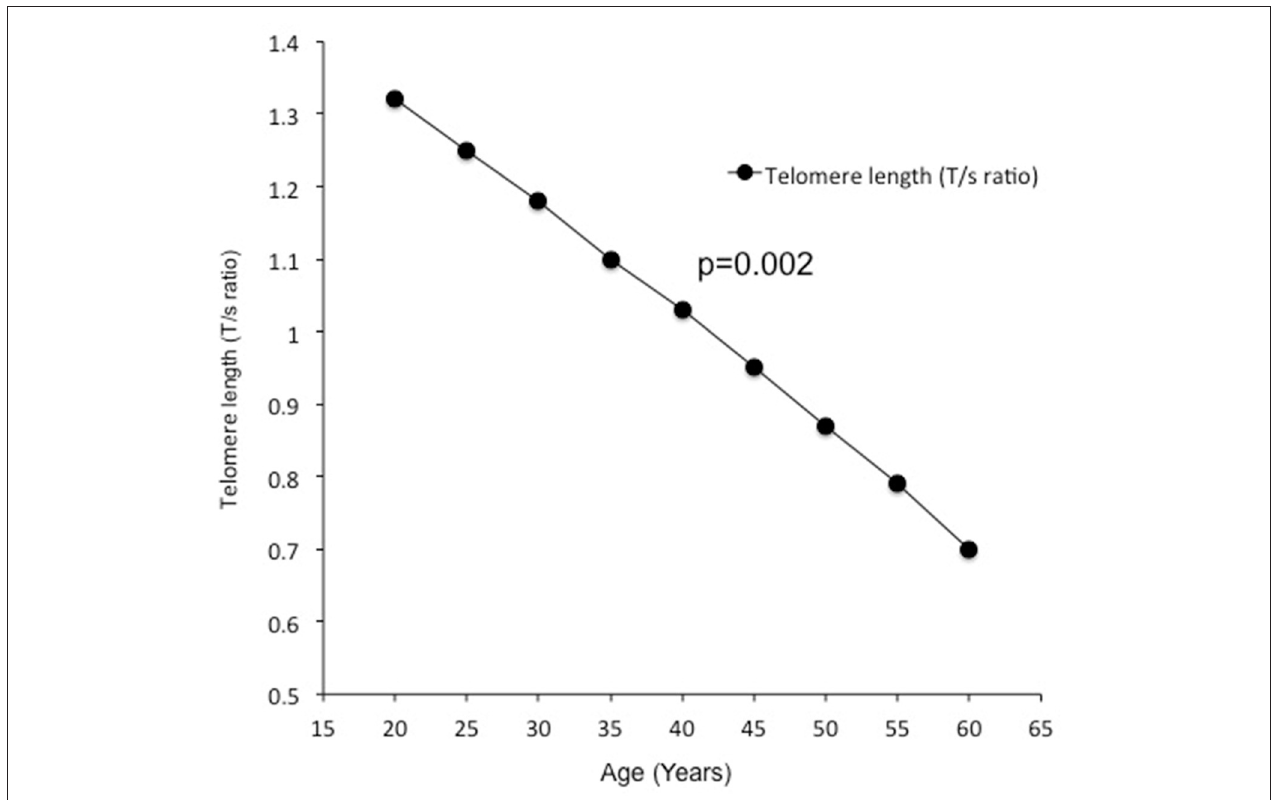
FIGURE 2 | Association of telomerase length with